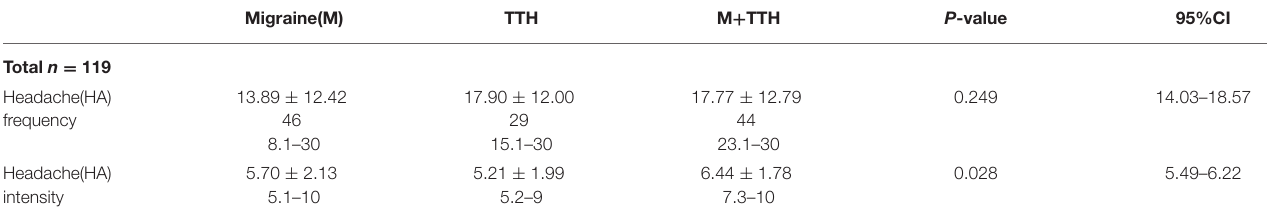
TABLE 2 | Frequency (days) and intensity (visual analog scale) of different subtypes of headaches in a large cohort of Chinese patients with HAMD when enrolled.